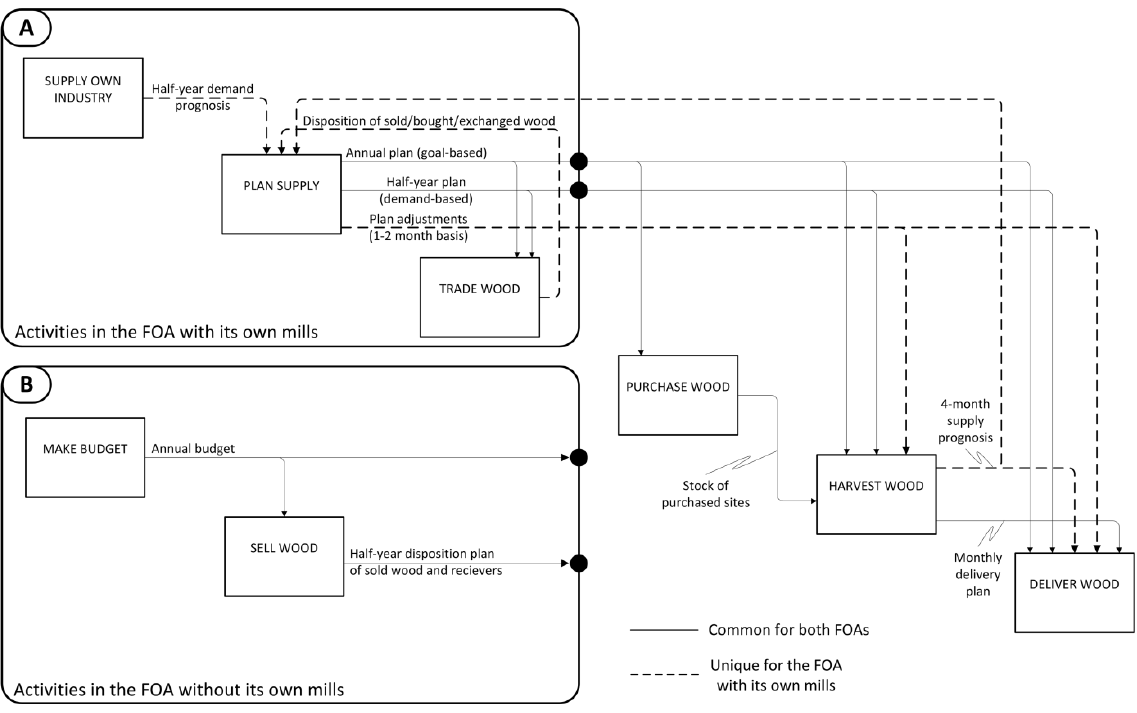
Figure 6. Information flows in tactical activities within the functions of the forest owners associations (FOAs). Inset A marks activities in the FOA with its own mills. Inset B marks the corresponding activities in the FOA without its own mills. The three right-hand activities (unmarked) were common for both FOAs. The dashed arrows indicate information flows that occurred only in the FOA with its own